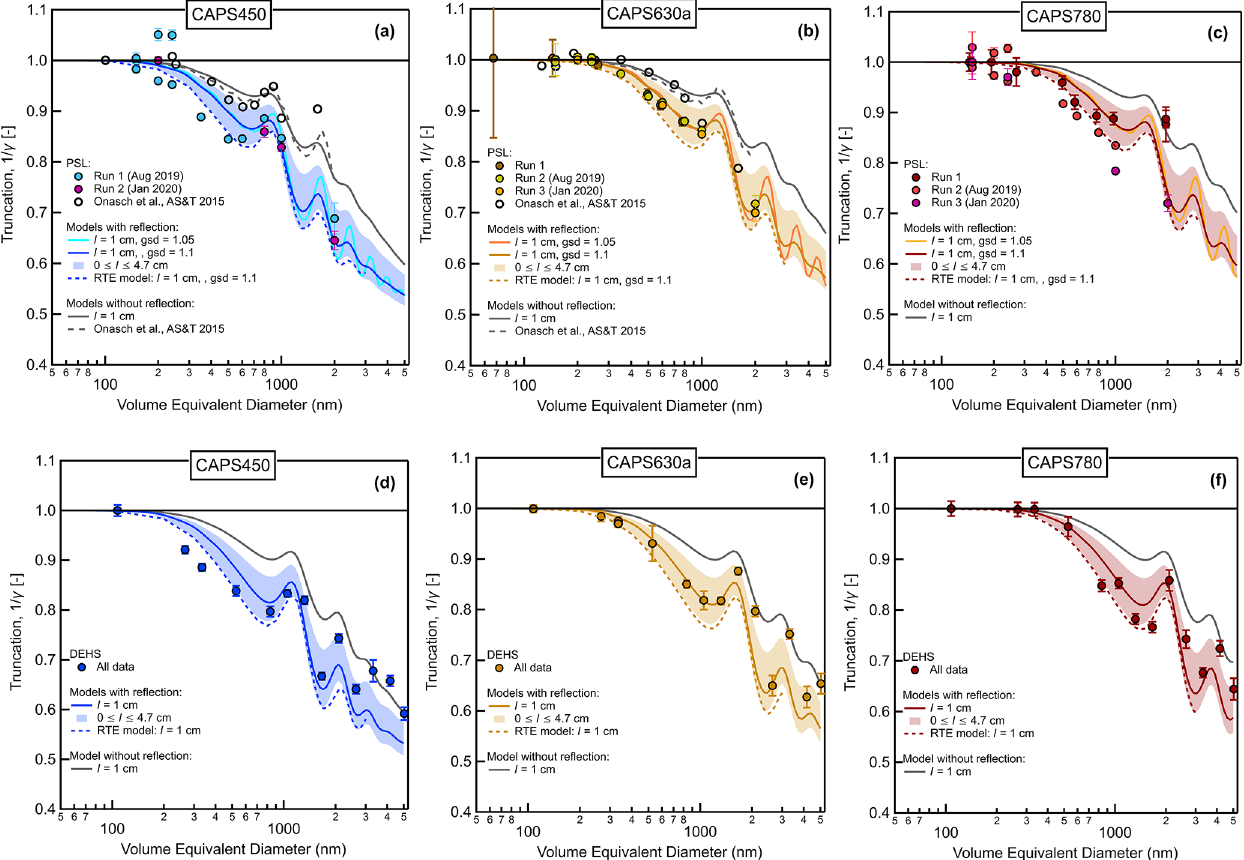
Figure 6. Measured and modeled truncation values as a function of volume-equivalent particle diameter for PSL and DEHS aerosols. The truncation values plotted on the y axes correspond to the inverse of the truncation correction factor γ defined by Eq. (4). Modeled curves were calculated with the truncation model presented in Appendix A as well as the radiative transfer equation (RTE) model presented by Liu et al. (2018). The parameter l represents the extra path length beyond the integrating sphere, and gsd refers to the geometric standard deviation of the modeled test